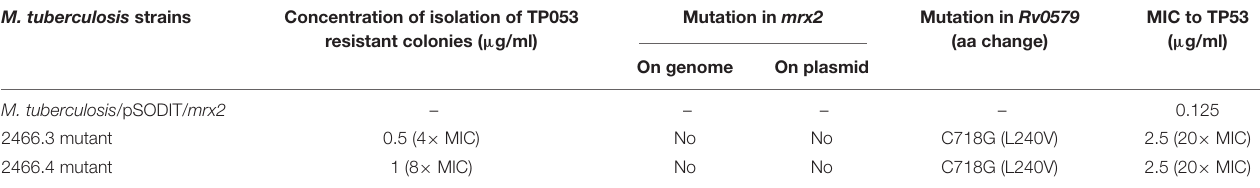
TABLE 1 | Characteristics of the M. tuberculosis spontaneous TP053 resistant